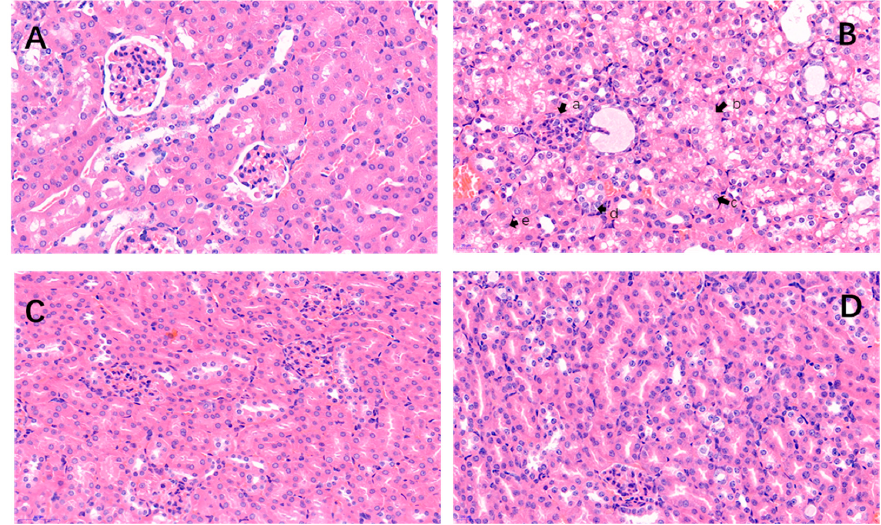
Figure 2. Histopathological changes. Renal micrographs of hematoxylin and eosin (H&E) staining (400 ×) of the control ( A ), OTA ( B ), astaxanthin (ASX) ( C ), ASX and OTA groups ( D ). n = 6 mice/group. In the control and ASX groups, intact kidney tissue structures were observed. In contrast, in the OTA-treated group, glomerular swelling and congestion (a), vesicular degeneration of renal tubular epithelial cell (b), pyknosis (c), karyorhexis (d) and karyolysis (e) were observed. The arrows “ ” indicate a pathological injury in the kidney. 2.3. Electron Microscopic Observation Under transmission electron microscopy, the kidney cells were closely arranged and intact in the control group (Figure 3A) and the ASX group (Figure 3C). The mitochondria had a clear structure, the mitochondrial cristae were neatly arranged, and uniform chromatin distribution was observed in the nucleus. In contrast, in the OTA treatment group (Figure 3B), the mitochondrial structure was disordered, the mitochondrial cristae disappeared, the nuclear chromatin was dispersed, the basement membrane was thickened, the nuclear membrane had disappeared, and the endoplasmic reticulum was swollen. In the ASX and OTA group (Figure 3D), the normal appearance of the mitochondria was restored, and the structure of the mitochondrial cristae and the nucleus was intact.